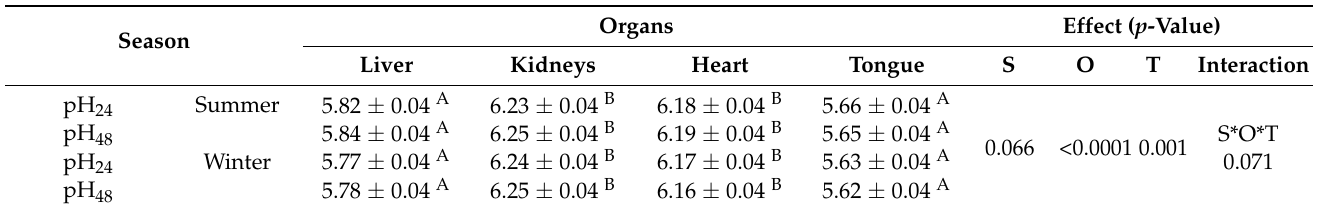
Table 5. Seasonal variation in the physicochemical traits of edible organs from the wild fallow deer (LSM ±